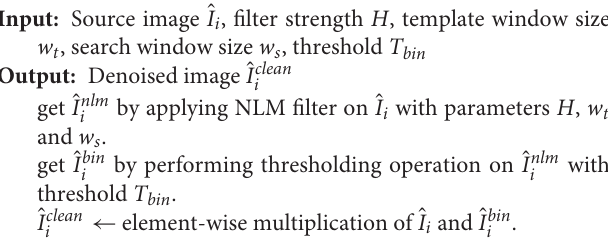
FIGURE 5 | The structure of WTSD. (A) The event frame buffer. (B) A transformed image in the W-T space. Rain streaks and system noise become approximately uniform noise. (C) The extracted motion curves. Note that the edges are hampered. (D) After processing all the images in the W-T space, rain free images in normal space are retrieved by performing the transformation reversely. (E) Using our repairing method, we get images having more edge details. Algorithm 1 | Remove rain and noise in the W-T curves have no reasons to be close at all, as pointed out in Buades et al. (2011).